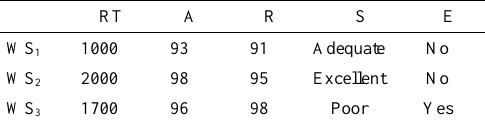
Table 3. Values of the selected QoS